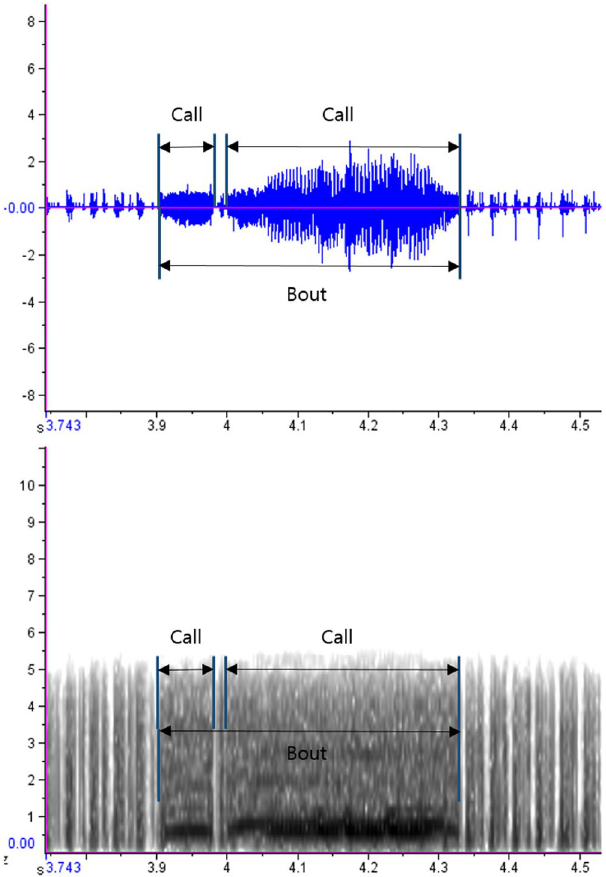
Figure 1. Oscillogram (top) and spectrogram (bottom) of a typical individual offshore call in the ocean (256- point fast Fourier transform, overlap 50%, Hanning window). The call comprises two notes that have different note durations.